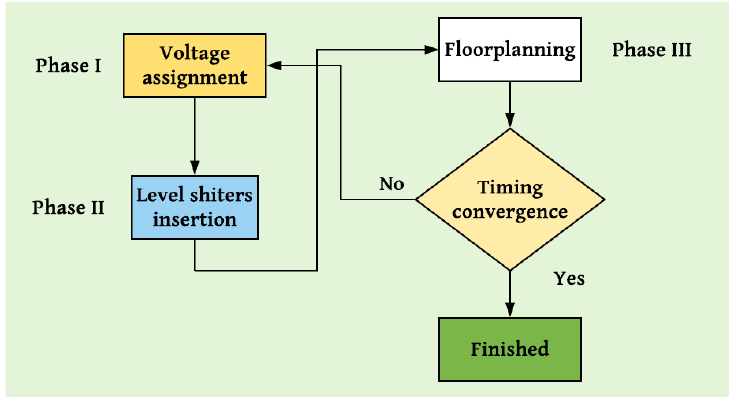
Figure 1. Multiple supply voltage design